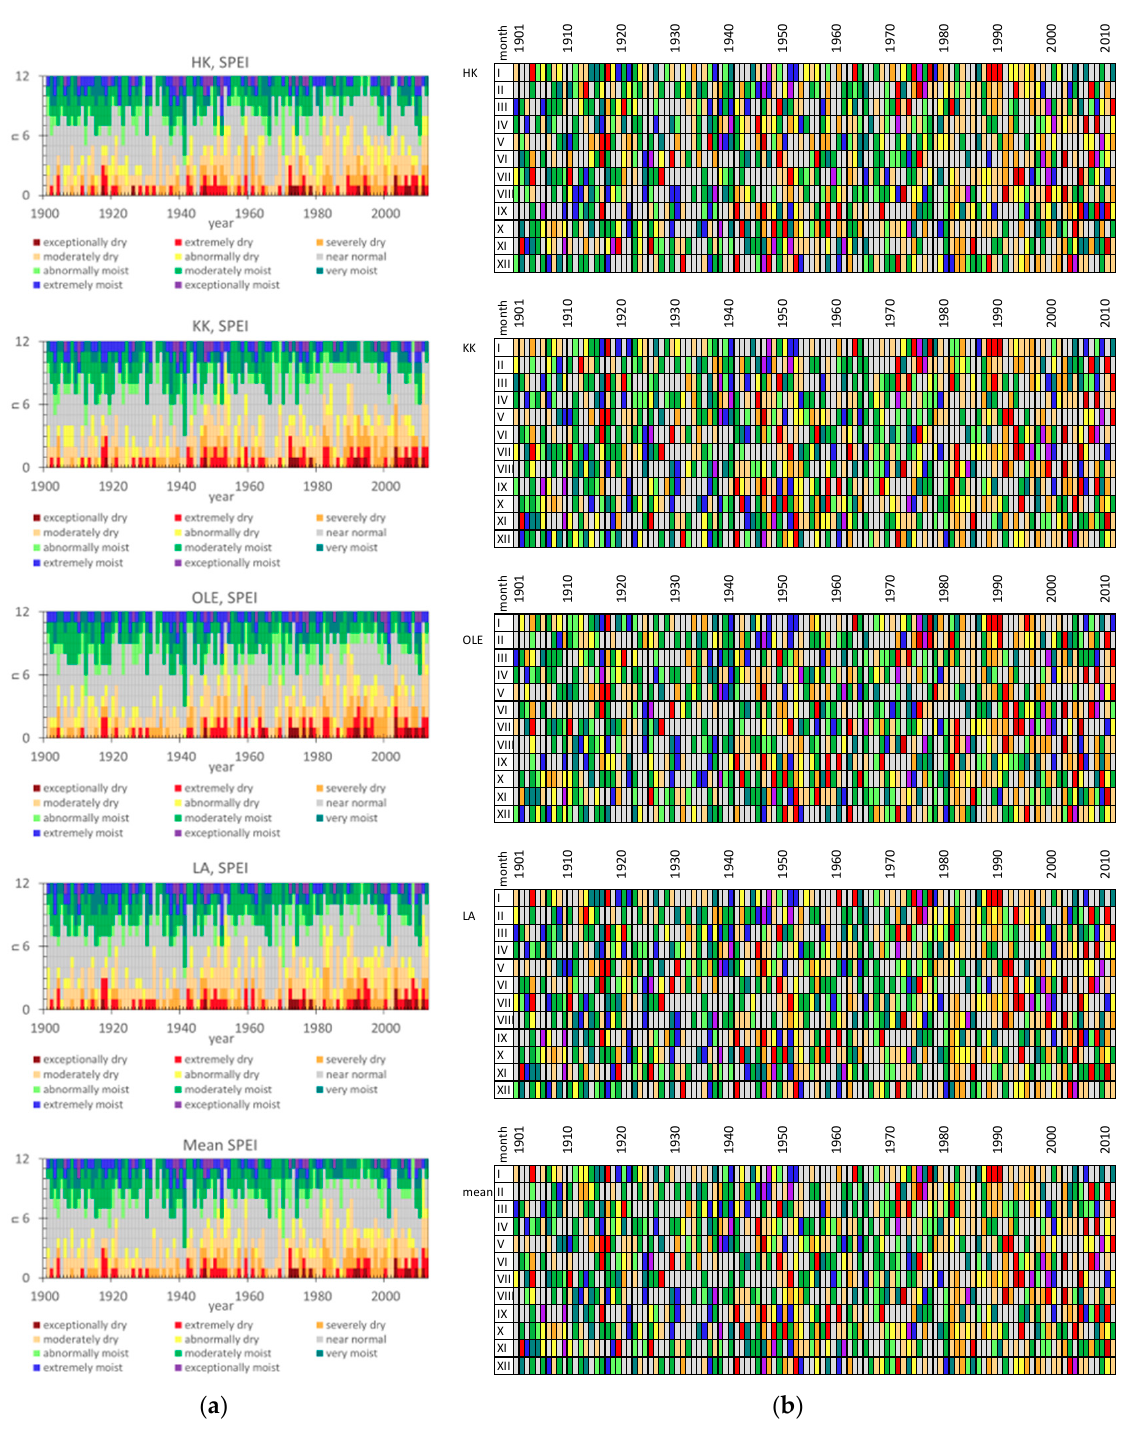
Figure 3. Graphical analysis of SPEI in the investigated area (HK-Dabrowa G ó rnicza, LA-Łaziska Górne, KK − K ę dzierzyn Ko ź le, OLE − Olesno and mean SPEI value in Silesia region) since 1900–2012. Comparison of time series, means, extremes, and trends of monthly SPEI ( a ) the number of months in each year (1900–2012) with the division to 11 types of the period depends on SPEI ( b ) the temporal distribution of variation in SPEI over each year since 1900–2012. The comparison according to the threshold and symbology for the SPEI [24], and data [23].